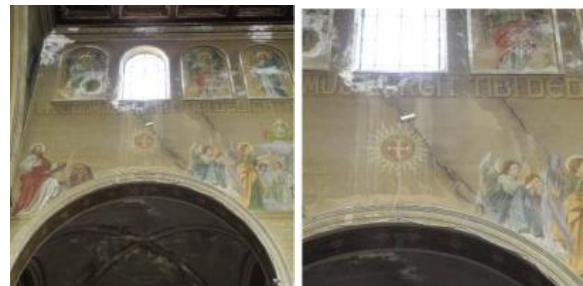
Figure 12. Images of the cracks present on the central walls, North side caused by soil settlements